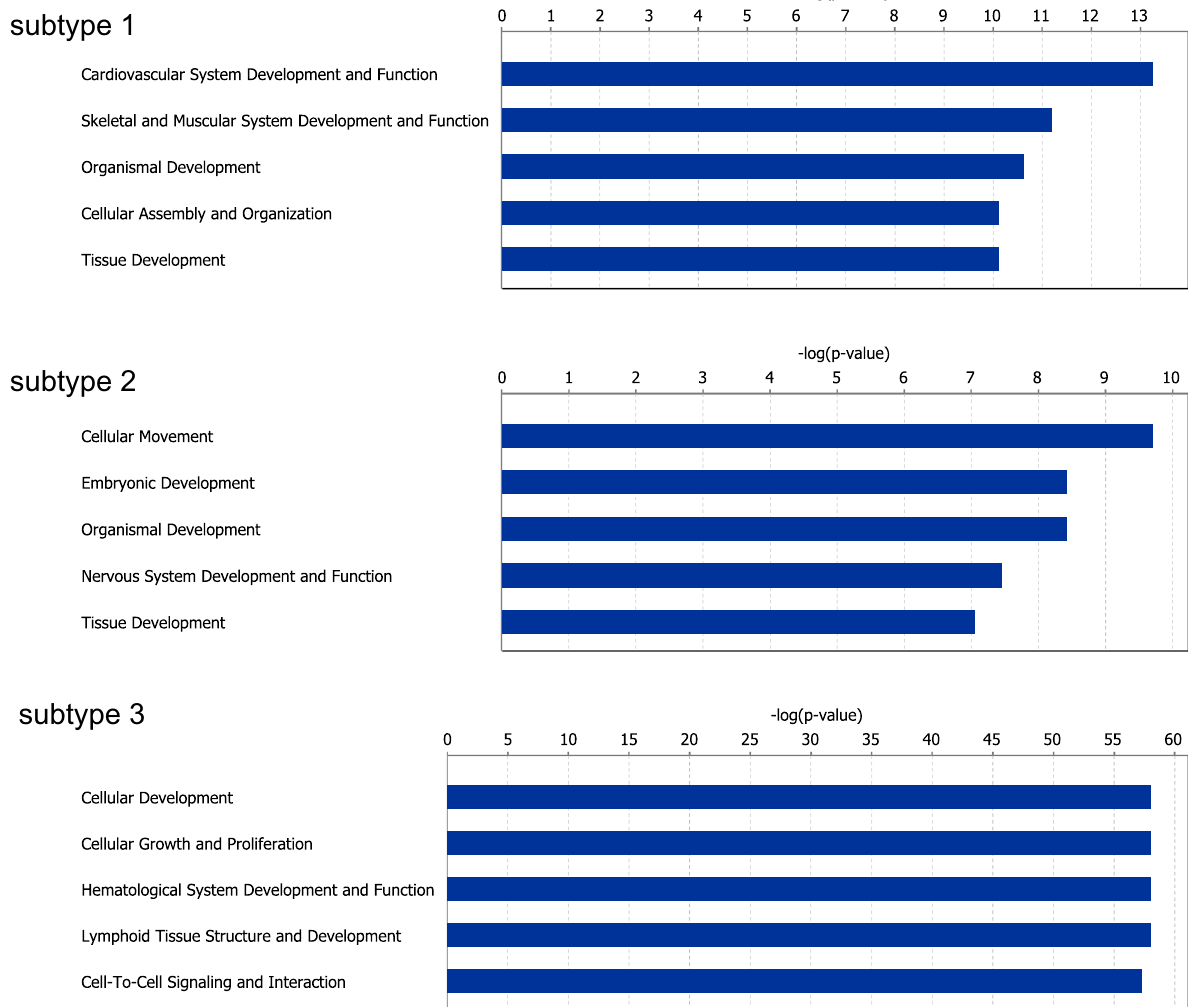
Figure 5. The top five terms of biological functions in the STAD